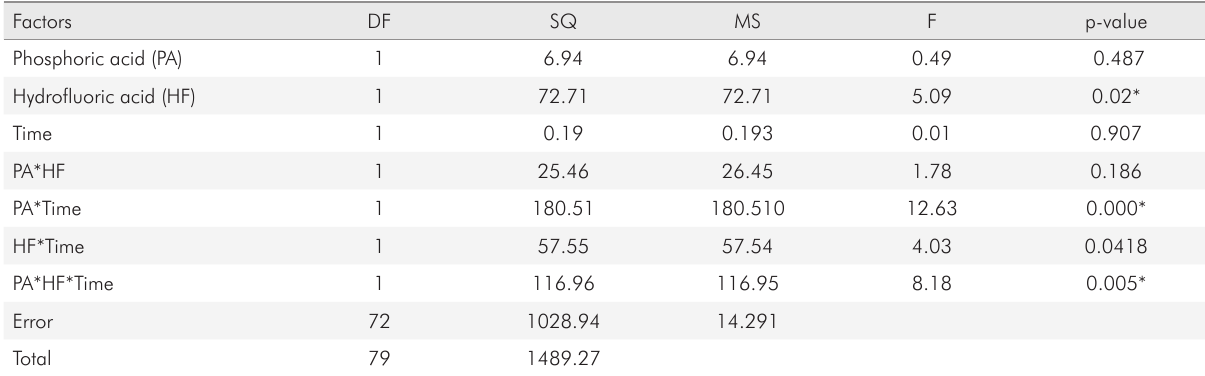
Table 2. Results of the 3-way ANOVA for shear bond strength.